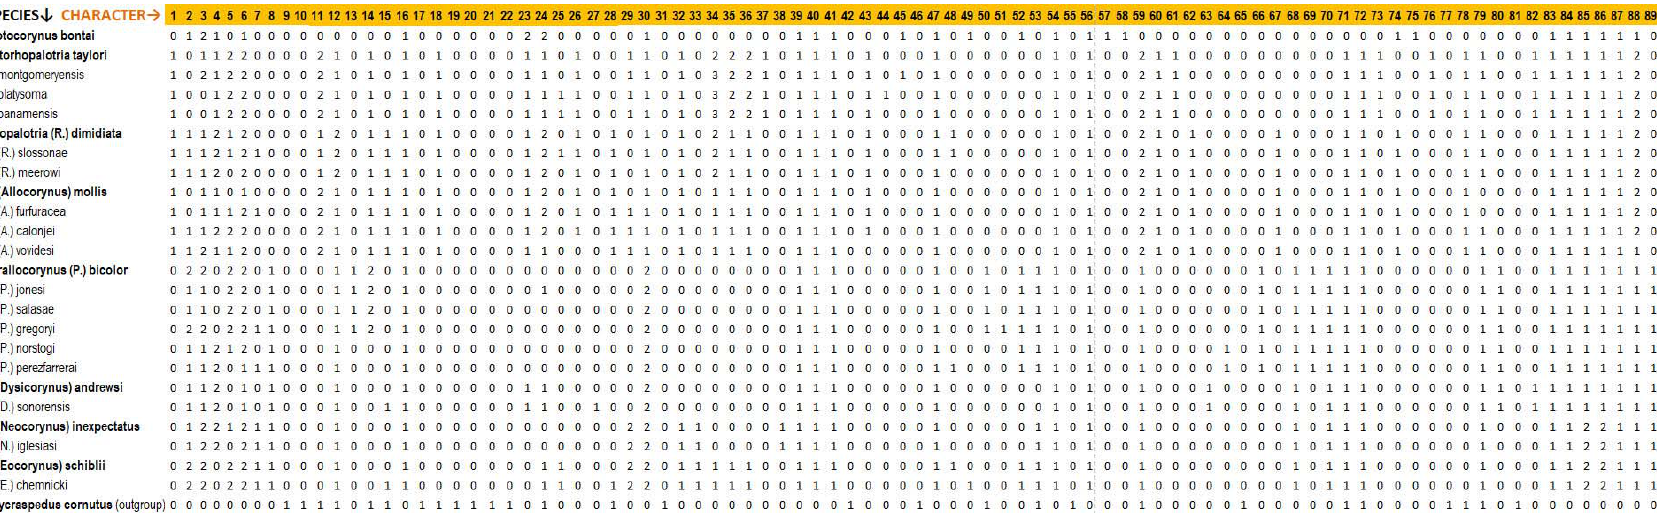
Figure A1. Character matrix for Allocorynina based on morphological, behavioral, and host-association characters (see Appendix A for description of characters states).